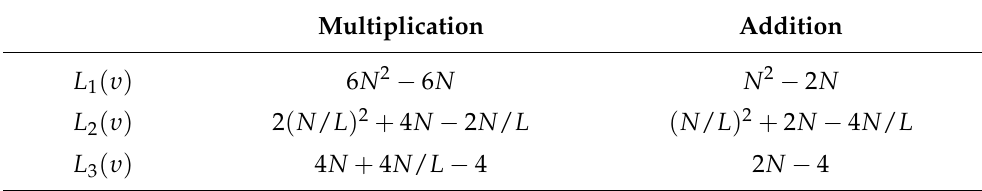
Table 1. Algorithmic complexity comparison of burst signal